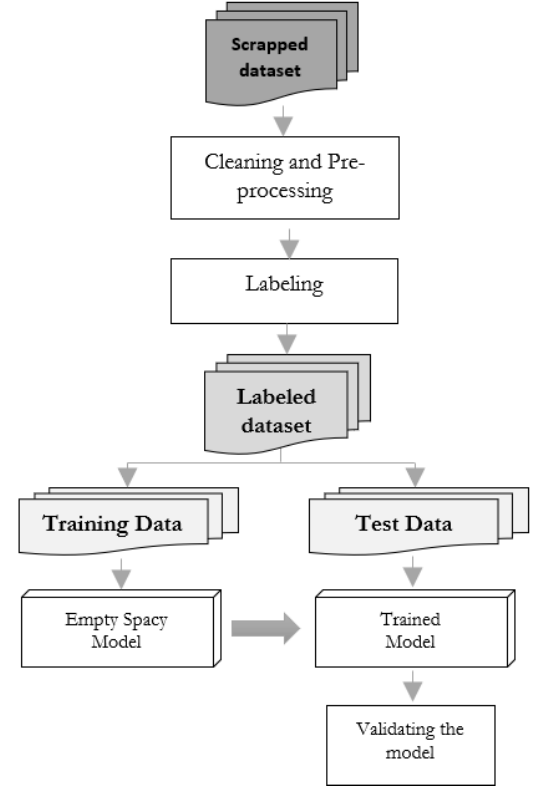
Figure 5. NLP-based training